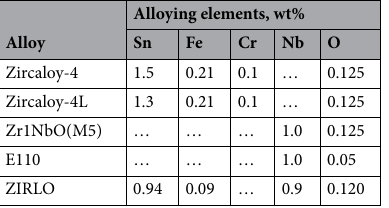
Table 1. Nominal chemical composition of some Zr-base alloys.